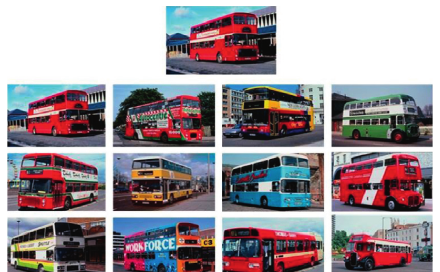
Figure 13: Retrieval of top 12 images as a result of search image selected from bus